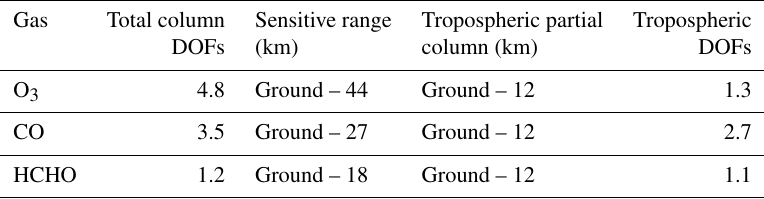
Table 2. Typical degrees of freedom for signal (DOFs) and sensitive range of the retrieved O 3 , CO, and HCHO profiles at Hefei site. Gas Total column Sensitive range